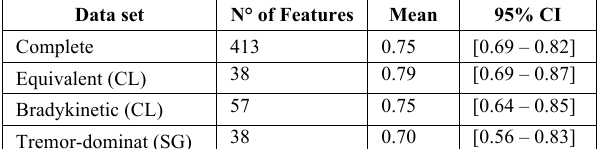
Table 1. Classification performance